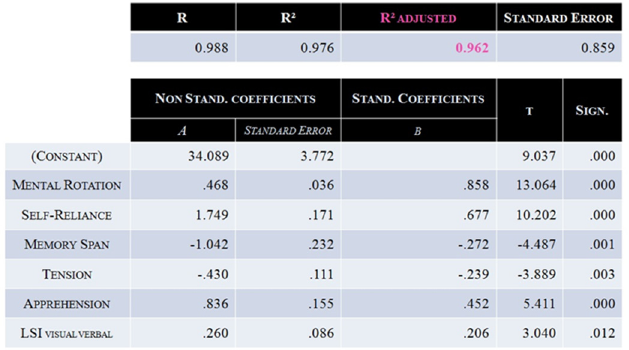
Fig 4. Characteristics of Model ] 1. This model included 6 factors: Mental Rotation, Self-Reliance, Memory Span, Tension, Apprehension and the “ Visual/Verbal ” dimension of the Learning Style. It enabled to explain 96.2% participants MI-BCI performance variance [ R 2 adj = 0.962, p < 0.001].